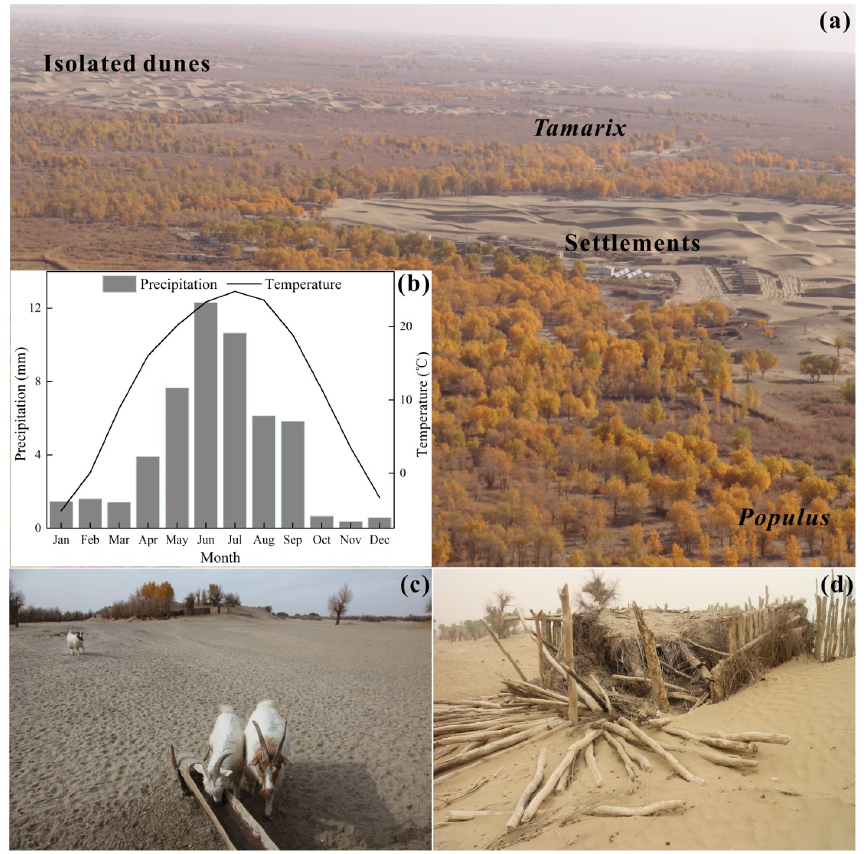
Fig 2. Photographs of Daliyaboyi natural oasis at the lower reaches of the Keriya River. (a) The vegetation (consisting of Tamarix and Populus) that surrounds the isolated dunes; the settlements are scattered in the delta; (b) Observed intra-annual variations in precipitation and temperature between 1961 and 2019 at the Yutian meteorological station located along the middle reach of Keriya River catchment; (c) Photograph of large-scale degradation and the general lack of desert riparian forests; (d) Photographs showing abandoned dwellings in the hinterland of the Taklimakan Desert. The study area is open to Chinese scholars for observation, and permits are not required to enter. Because these photographs were acquired during field observations by the authors of this article, the copyright belongs to this article.